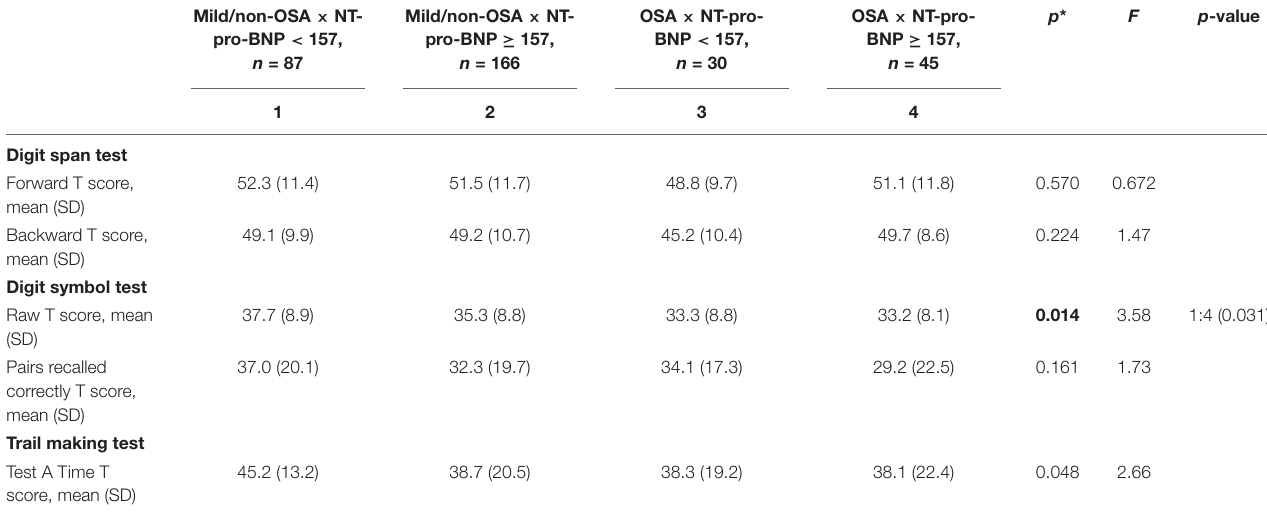
TABLE 2 | Means differences of the cognitive functioning in the four groups stratified according to the presence of obstructive sleep apnoea and the level of NT-pro-BNP (high vs. low). Mild/non-OSA × NT- pro-BNP < 157,